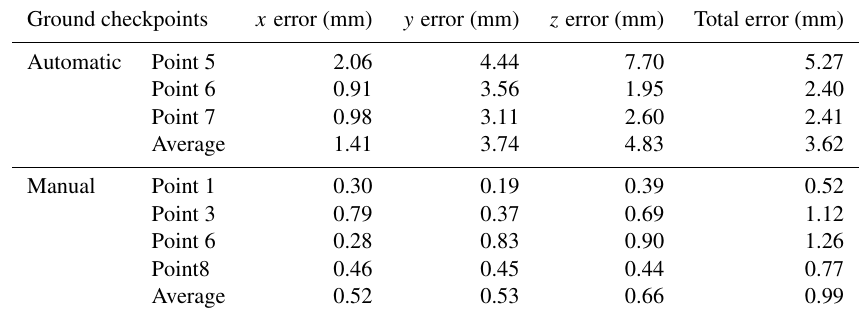
Table 3. Checkpoint RMSE for manual and automatic photogrammetry. Ground